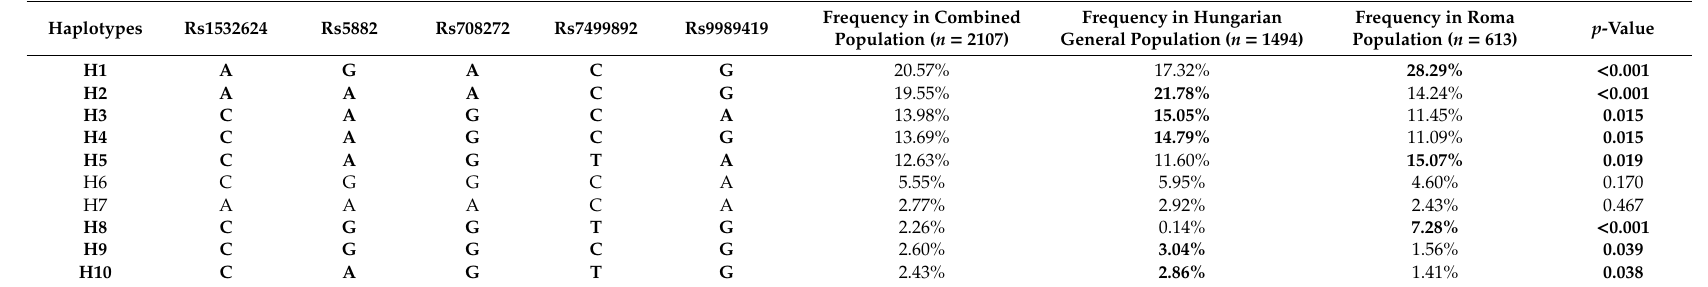
Table 2. The frequency of haplotypes in CETP gene in the combined sample, as well as in Roma and Hungarian general populations.